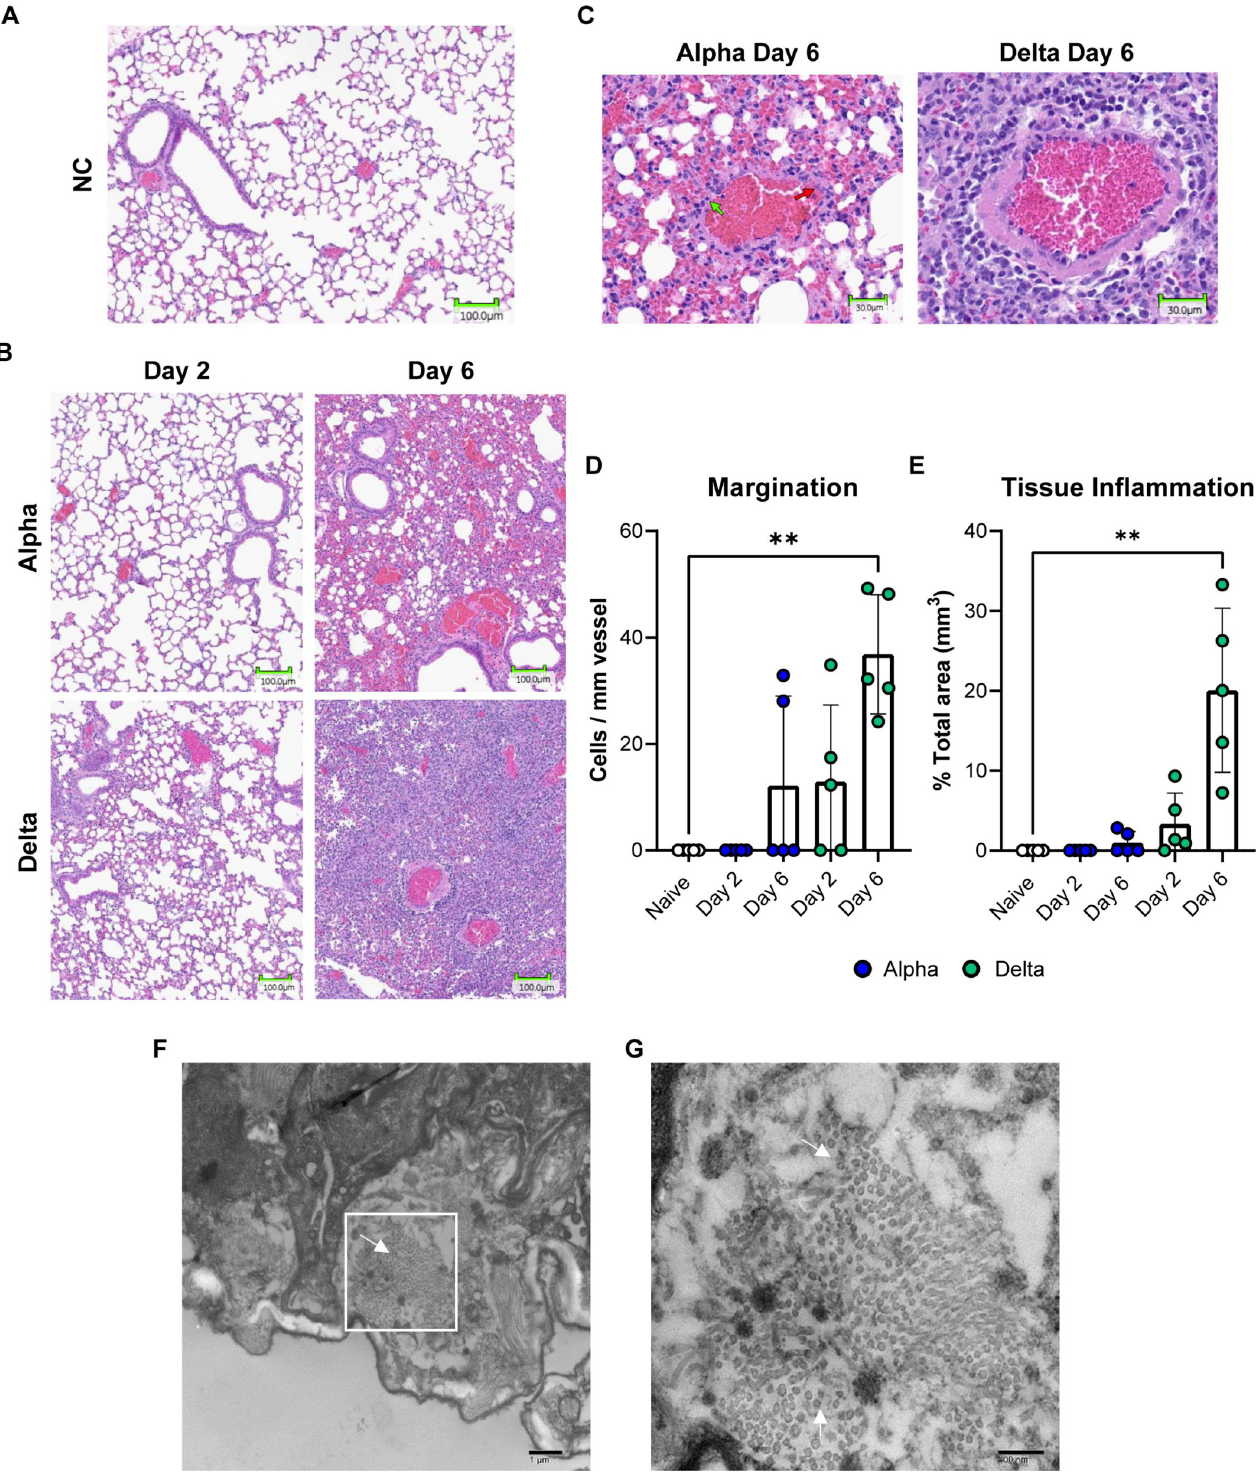
Fig 3. Histopathological and electron microscopy analysis of Alpha or Delta challenged K18-hACE2-mouse lungs. 20X images demonstrating inflammation in the lung tissue of Alpha and Delta SARS-CoV-2 challenged K18-hACE2 at Day 2 or 6 post-challenge (B) compared to no challenge (A). 20X images reveal margination at blood vessels within areas of inflammation (green arrows indicate counted marginating cells, red arrows indicate tissue-resident non-marginating cells)(C). Marginating inflammatory cells were counted within the tissue and were found to be increased in Delta challenge at Day 6 (Kruskal